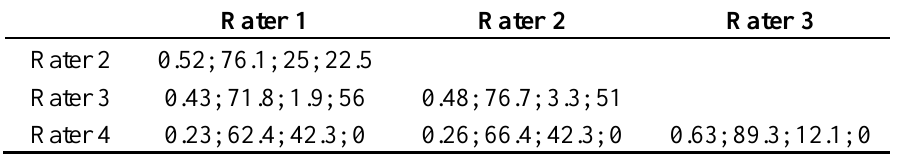
Table 2. Agreements (Weighted Kappa statistics; percentage agreement; false positive rate; false negative rate) between the four raters when rating the motor symptom (bradykinesia and dyskinesia) in animated spirals. All Kappa statistics are highly significant (each p < 0.001).